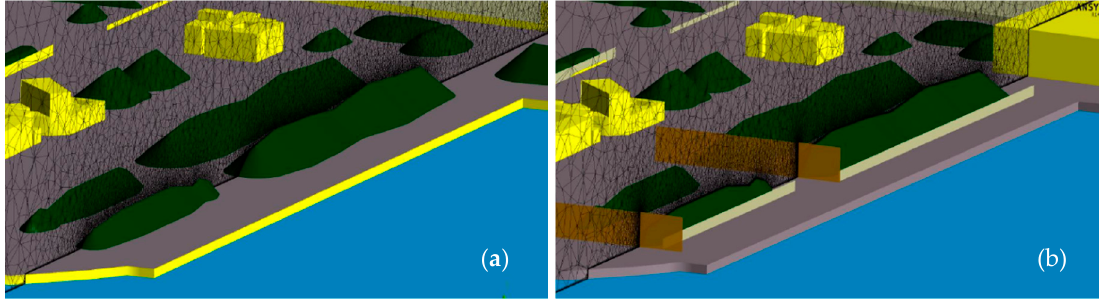
Figure 3. Finite volume model details; ( a ) Initial situation; ( b ) Finally, with wind